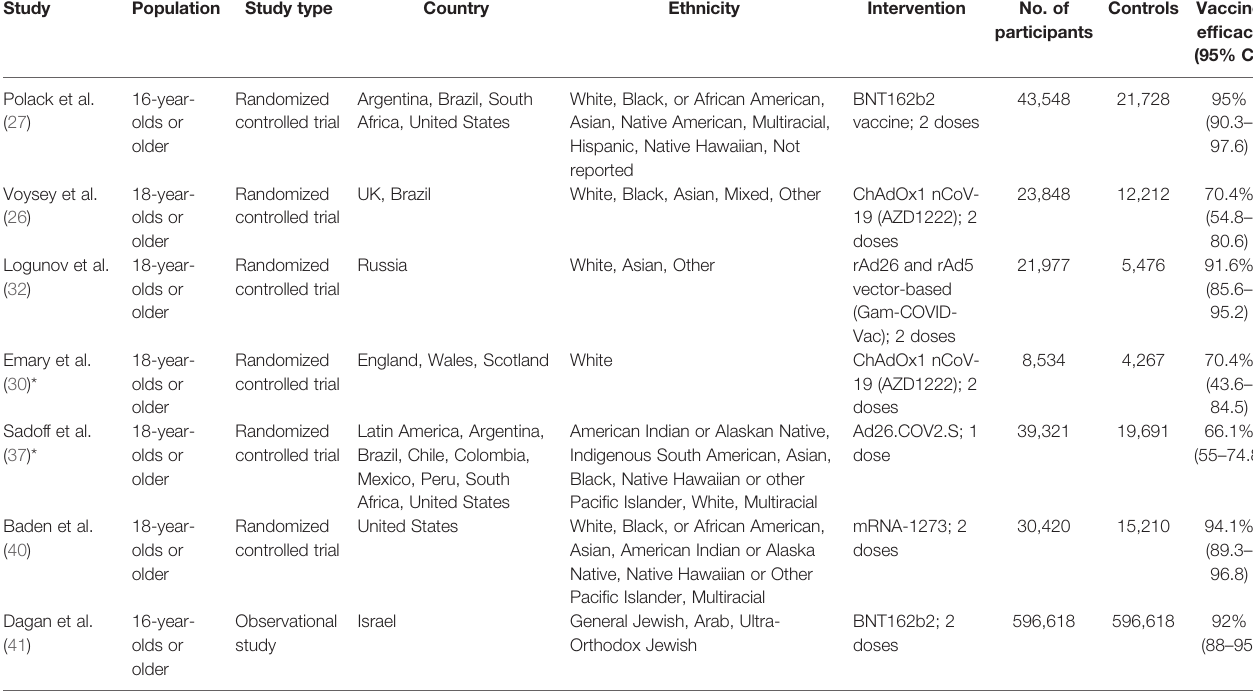
TABLE 2 | Randomized controlled trials and observational studies ful fi lling the inclusion criteria for the ef fi cacy of COVID-19